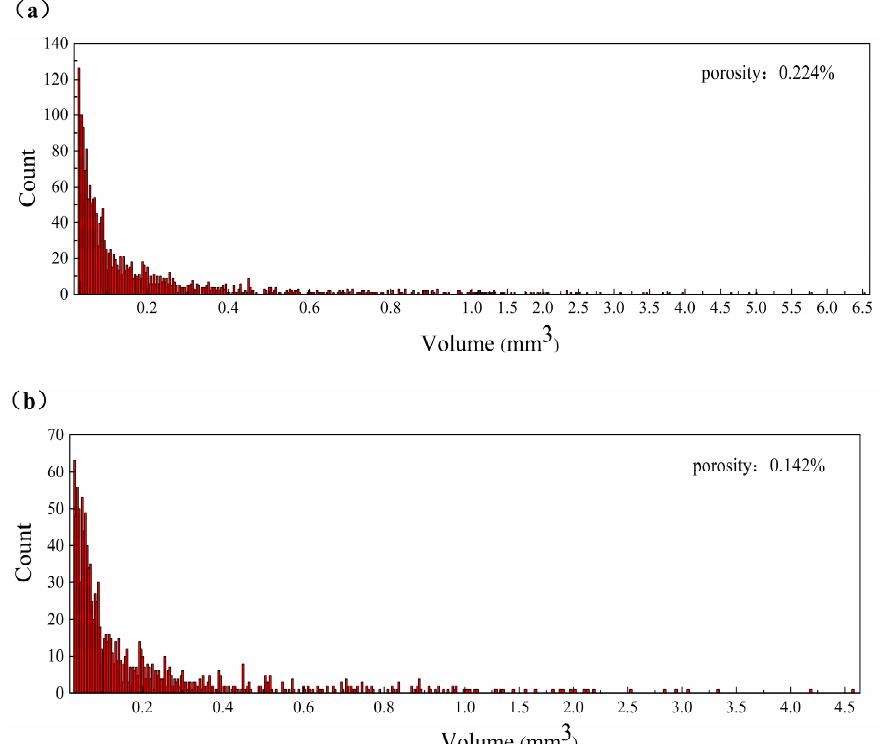
Figure 6. Size distribution of the voids for composite shells: ( a ) size distribution of voids for helmet prepared by RTM process; ( b ) size distribution of voids for helmet prepared by M-CRTM process.